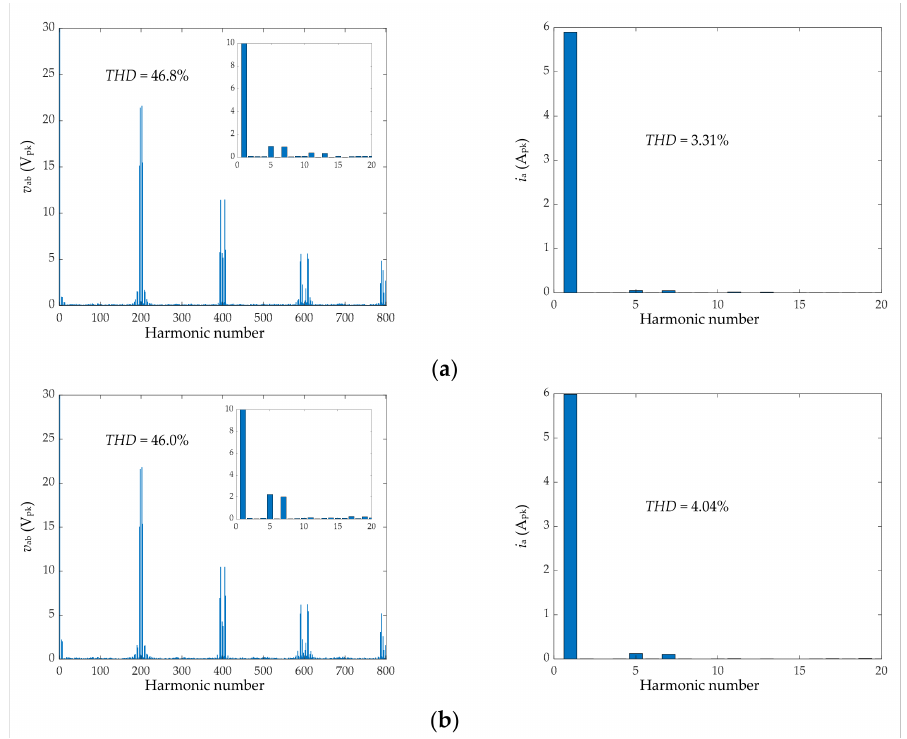
Figure 10. Line-to-line voltage and phase current harmonic distortion under m = 1.025 and hbc = 1. ( a ) Algorithm implemented with Algorithms 1 and 2; ( b ) algorithm implemented with Algorithms 2 and 3.